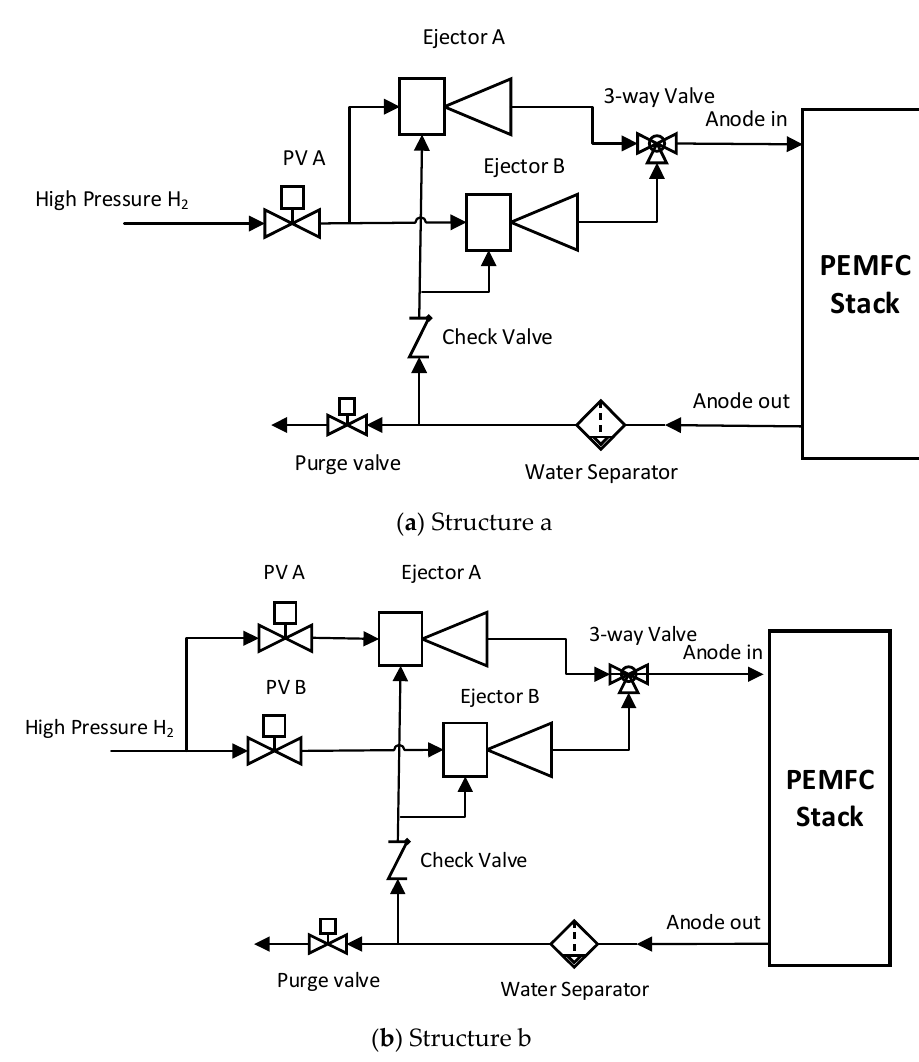
Figure 2. Dual ‐ ejector hydrogen supply and recirculation system: ( a ) using one proportional valve (PV A); ( b ) using two proportional valves (PV A and PV B).